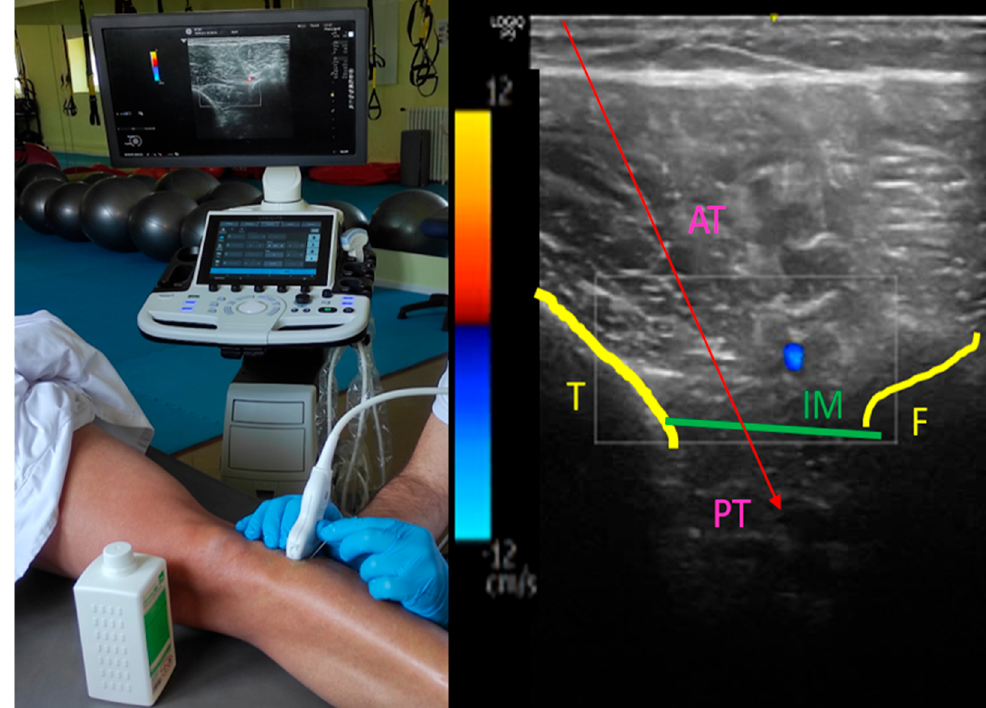
Figure 1. Ultrasound − guided dry needling. Upper third of the leg; AT, followed by the interosseous membrane (IM) as a hyperechoic band between the tibia (T) and fibula (F), sparing the neurovascular component (anterior tibial artery and vein, and deep peroneal nerve), to finally visualise